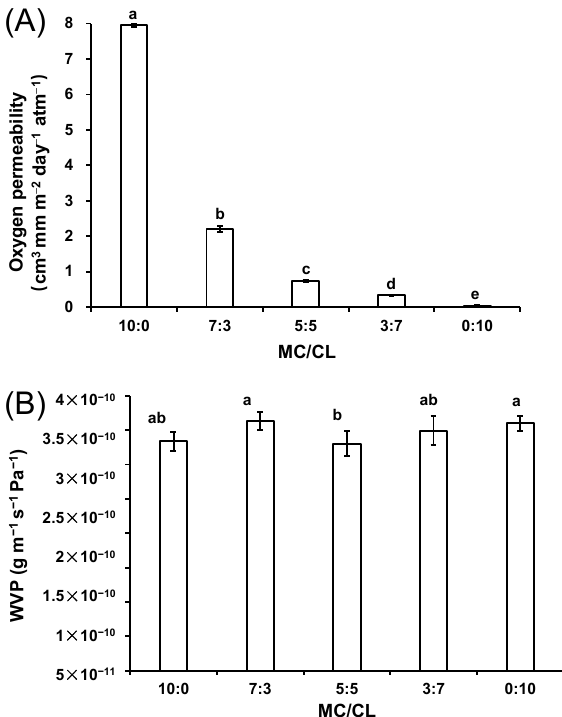
Figure 5. Oxygen permeability ( A ) and water vapor permeability ( B ) of the MC/CL films with different blend ratios. Different letters indicate significant differences ( p < 0.05).